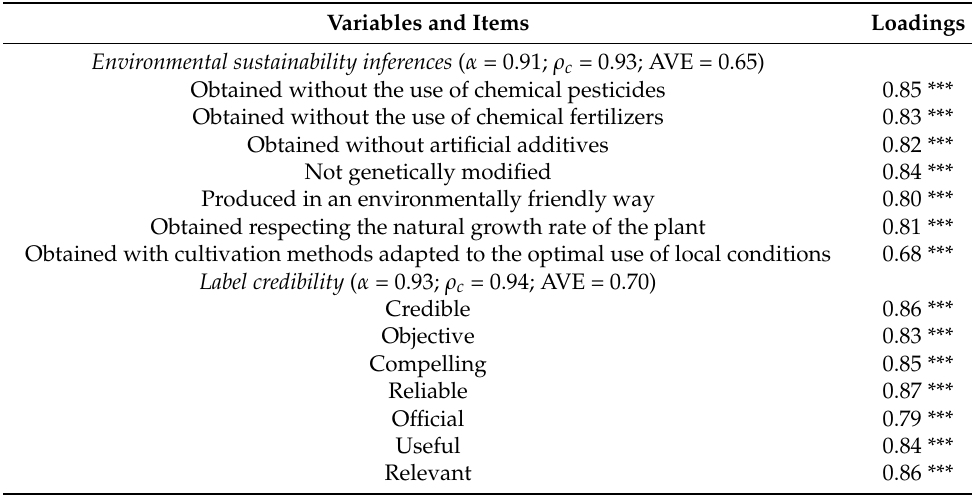
Table 1. Measurement model